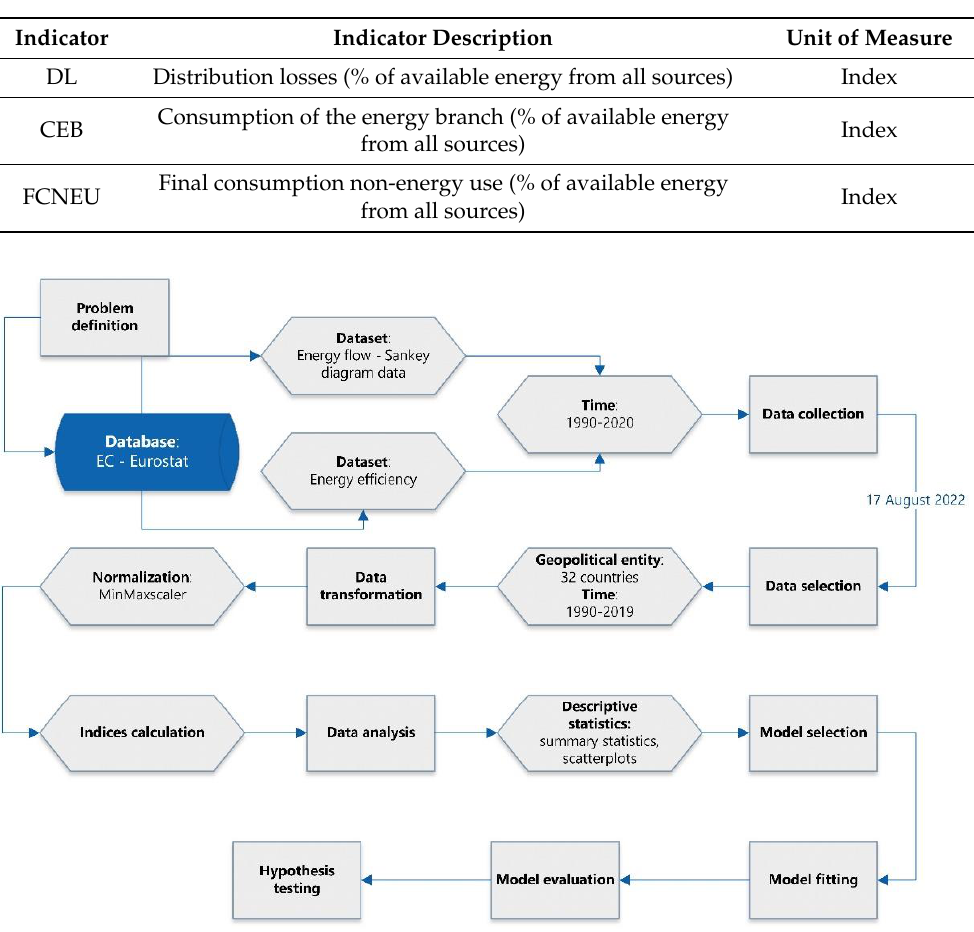
Figure 1. The flowchart diagram of the research process.